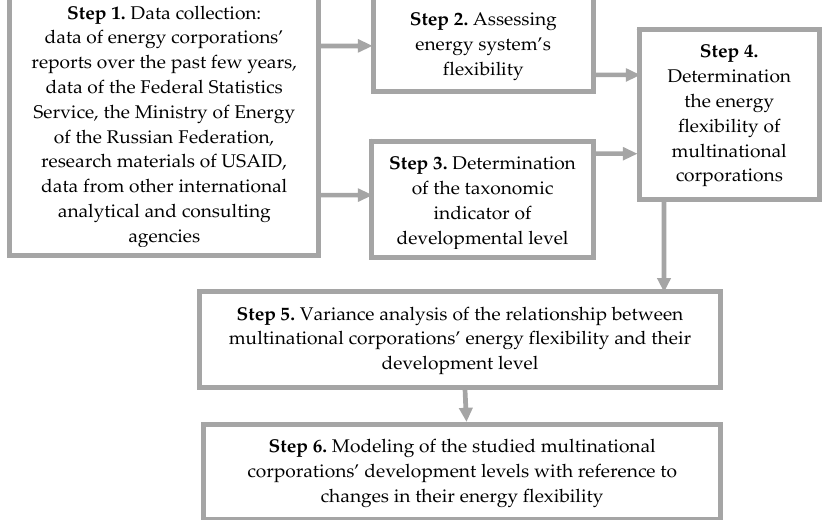
Figure 1. Research logic. Source: developed by the authors.